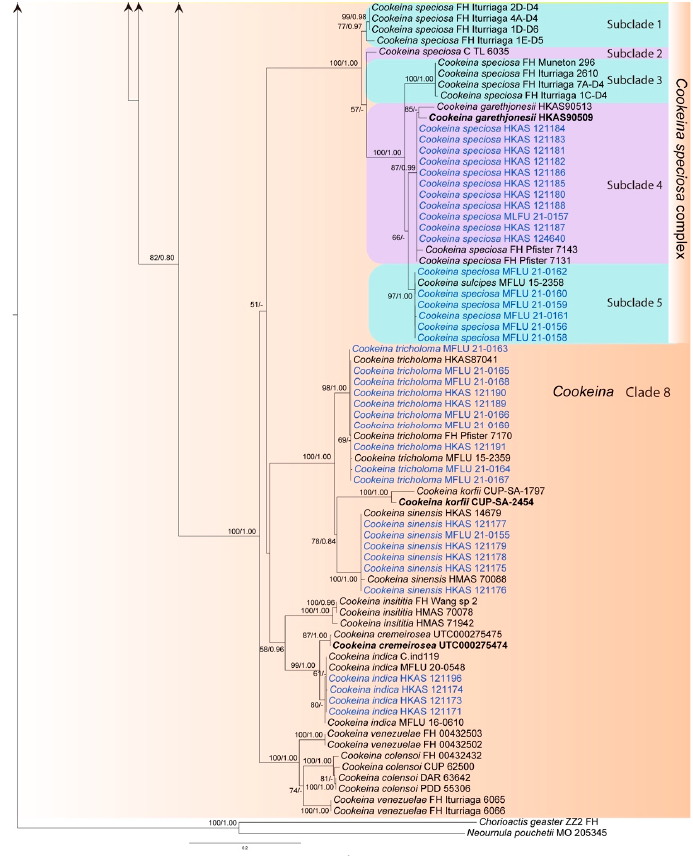
Figure 1. Maximum likelihood tree of ITS sequence data inferred from 151 taxa and 476 sites under the GTR (general time reversible) + G + I model of nucleotide substitution. Bootstrap support val ‐ ues for maximum likelihood (BS) and Bayesian posterior probabilities (PP) greater than 50% and 0.80 are indicated above or below the nodes in this order. Names in red indicate newly ‐ described species and names in blue stand for newly ‐ sequenced collections. Names in green indicate correc ‐ tion to Phillipsia domingensis ( a ). Chorioactis geaster (ZZ2 FH) and Neournula pouchetii (MO 205345) are used as the outgroup taxa ( b ).